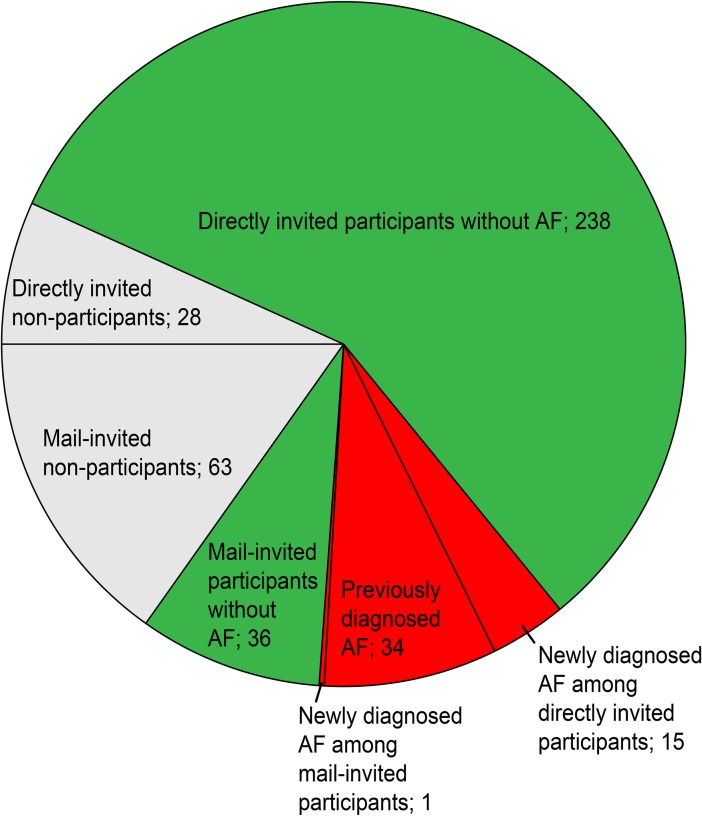
Screening results.